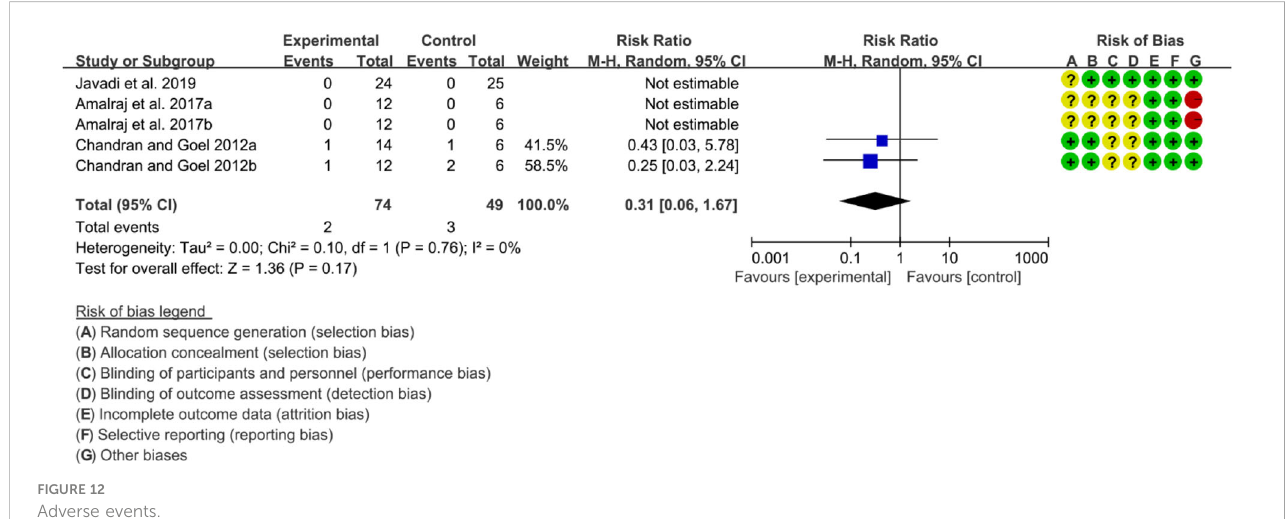
FIGURE 12 Adverse events.